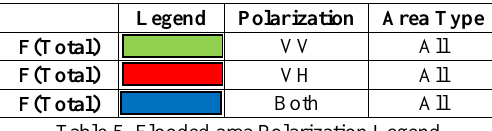
Table 5. Flooded area Polarization